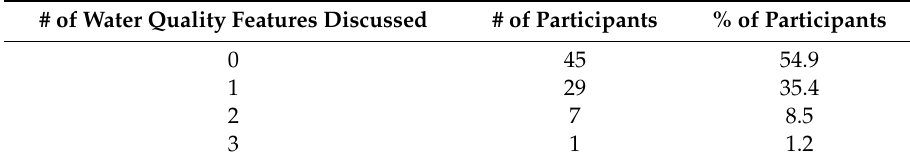
Table 5. Participant-generated definitions of water quality